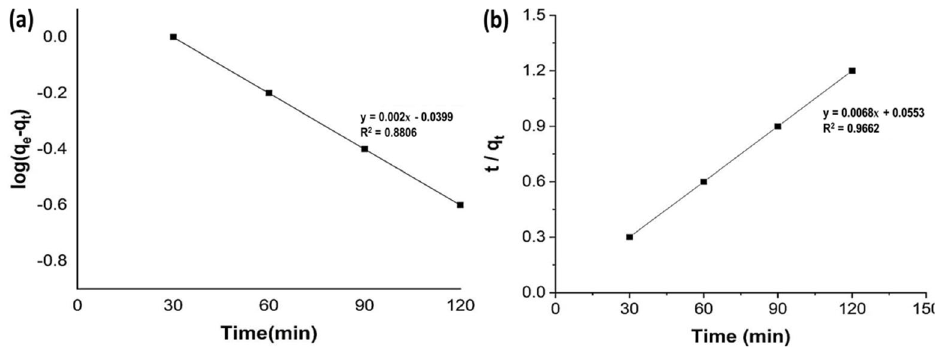
Figure 7. Pseudo ‐ first ‐ ( a ) and pseudo ‐ second ‐ ( b ) order kinetic model for methyl orange adsorp ‐ Figure 7. Pseudo-first- ( a ) and pseudo-second- ( b ) order kinetic model for methyl orange tion.